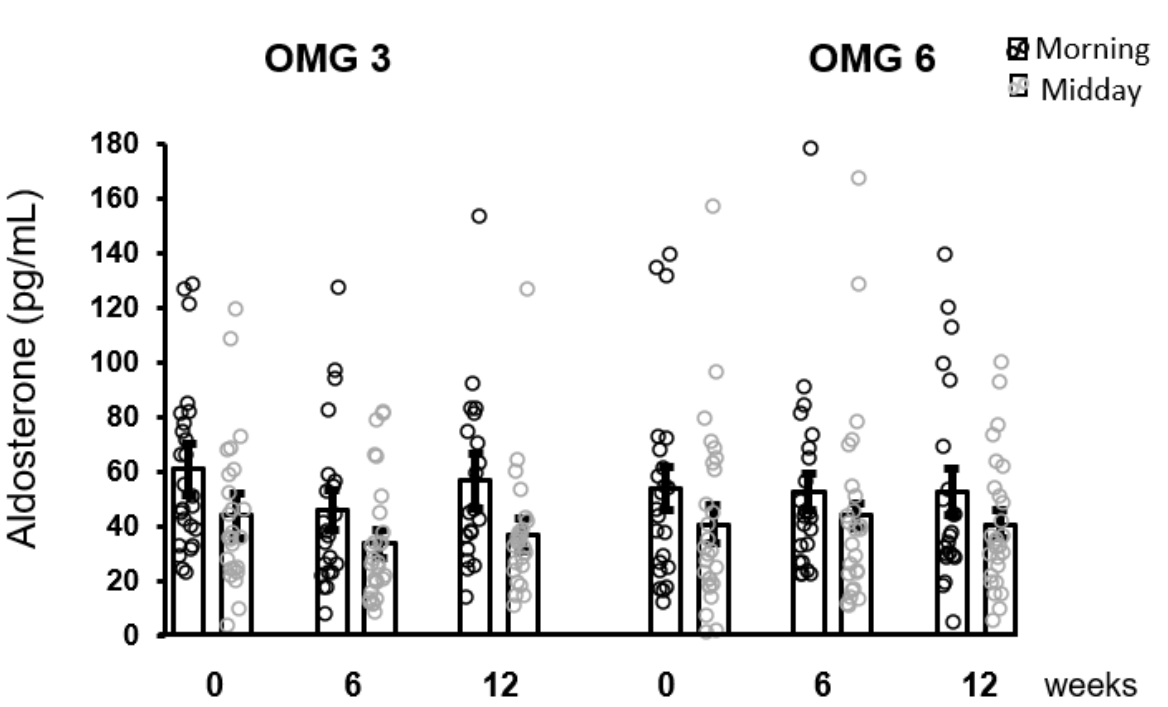
Figure 5. No effect of fatty acids supplementation on salivary aldosterone concentrations in the whole sample of patients. Results are expressed as dot plots with each dot representing an individual subject with means ± SEM. OMG 3—omega-3 fatty acid, OMG 6—omega-6 fatty acid.